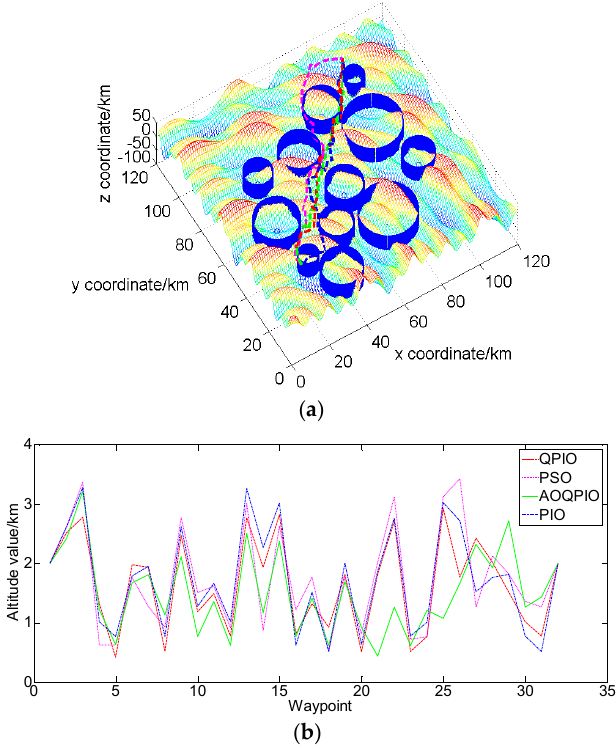
Figure 4. ( a ) is the result of all algorithms and ( b ) is the result of optimal UAV altitude of the experiment carried out in map 2.